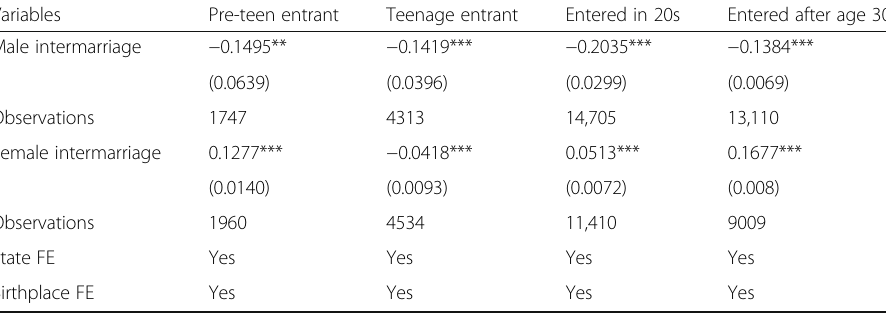
Table 8 Effects of intermarriage on household specialization: by immigrant age of entry Variables Pre-teen entrant